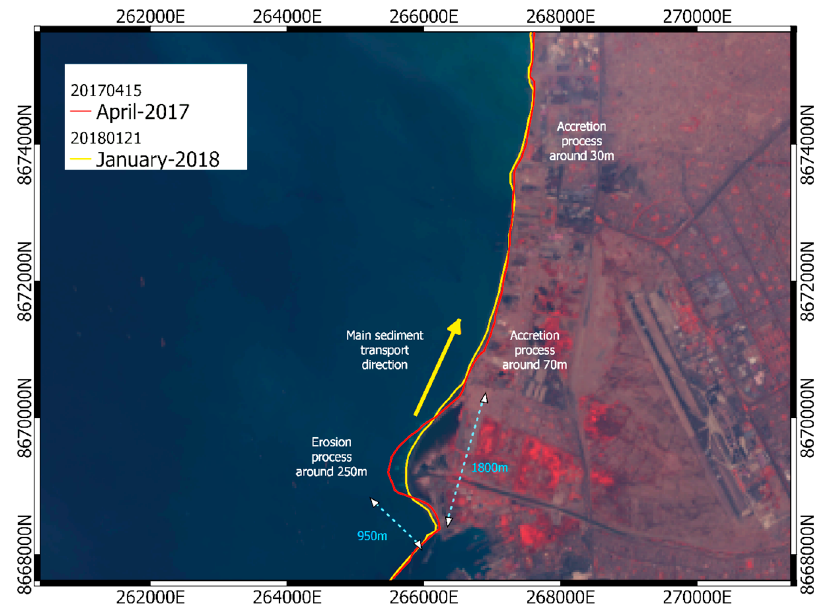
Figure 9. Shoreline evolution between April 2017 and January 2018.